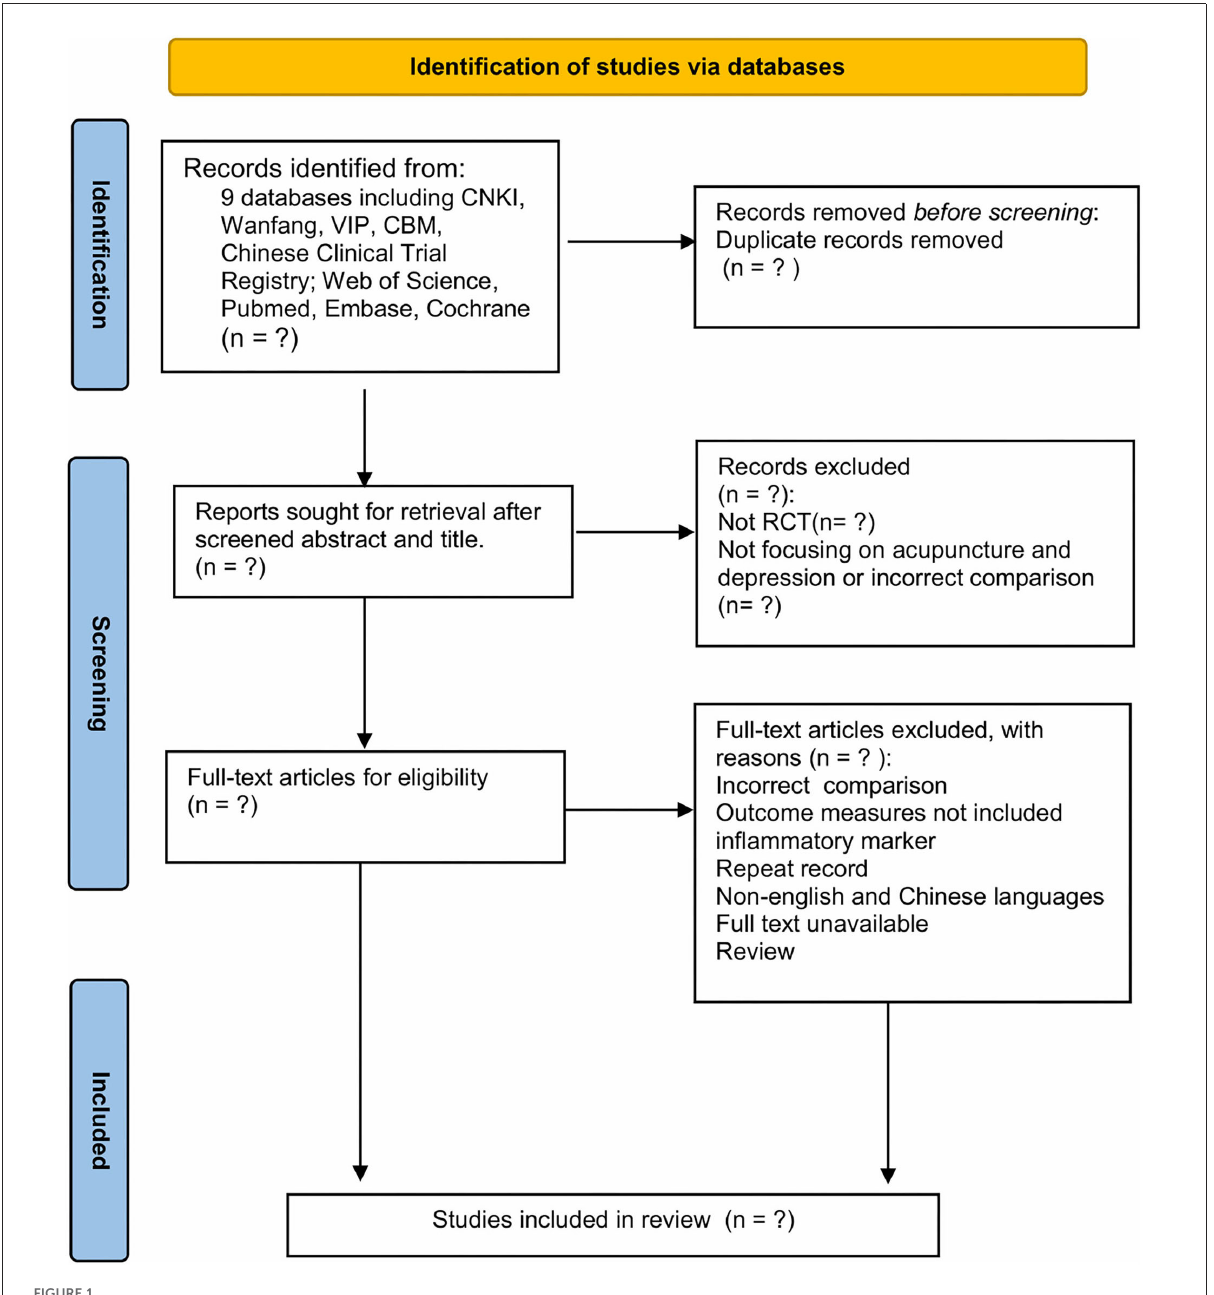
FIGURE1 PRISMA flow diagram of the study selection process. PRISMA, Preferred Reporting Items for Systematic Reviews and Meta-Analyses.